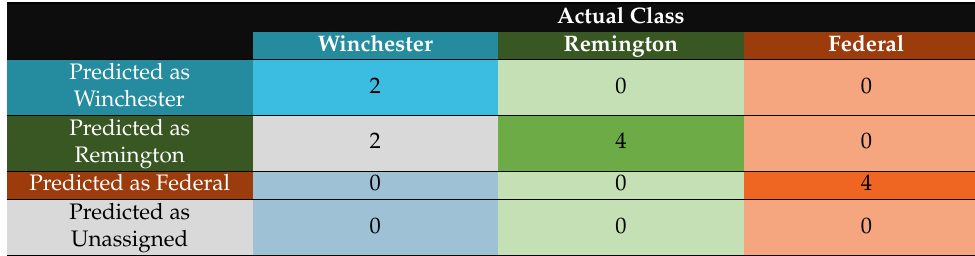
Table 4. Summary of overall results for manufacturer differentiation of the smokeless powder sample analysis shown in Table